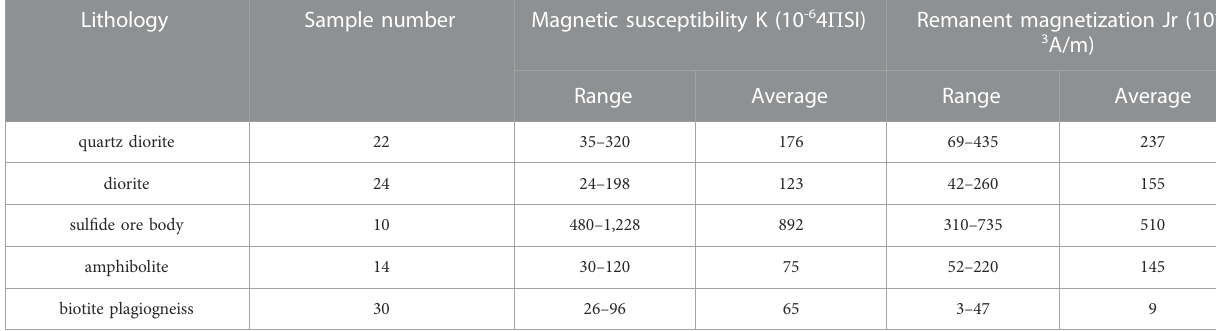
TABLE 2 The range and average values of susceptibilities of different lithologies in the Weilasituo-bairendaba district (after IMGECL